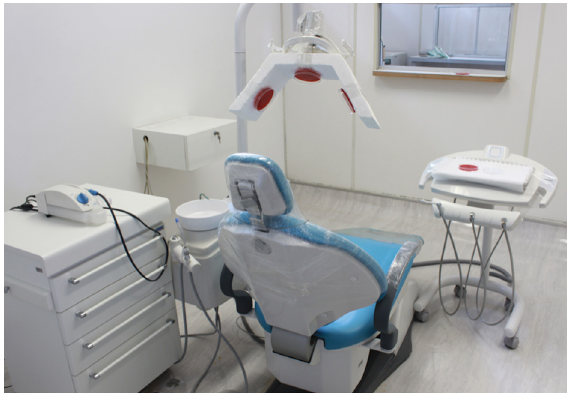
Figure 1. Microbial sampling technique used to evaluate the presence of microorganisms in the dental office before prophylaxis with an ultrasonic